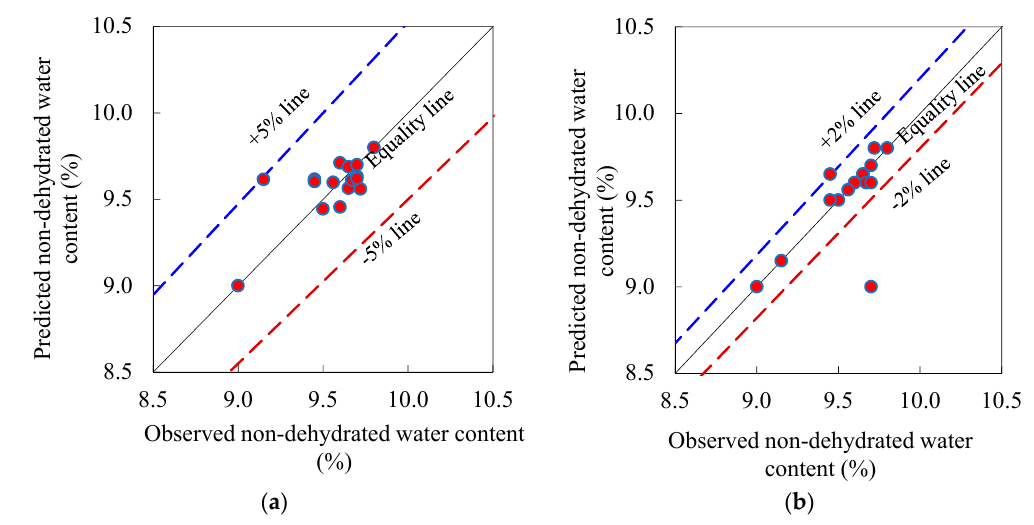
Figure 11. Actual vs. predicted 28-day non-dehydrated water content (%) of control and ternary blended pastes: ( a ) Quadratic model (Equation (16)) and ( b ) Cubic model (Equation (17)).